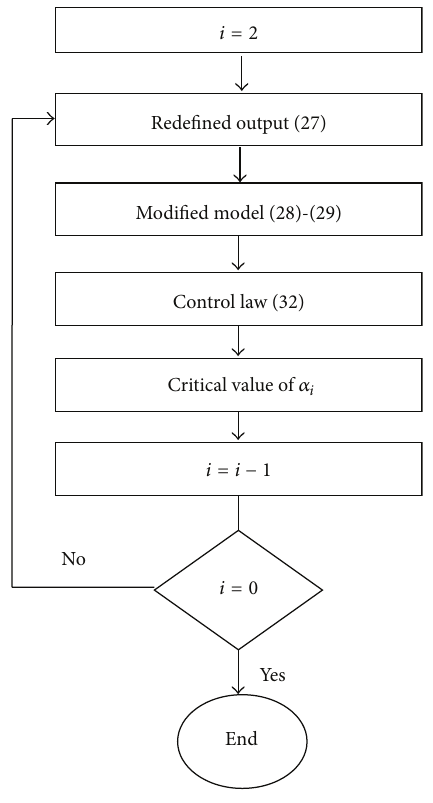
Figure 3: Distributed control